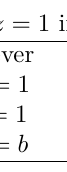
Table 3: Restrictions on the values of a and b in a · b = z when ∆ z =